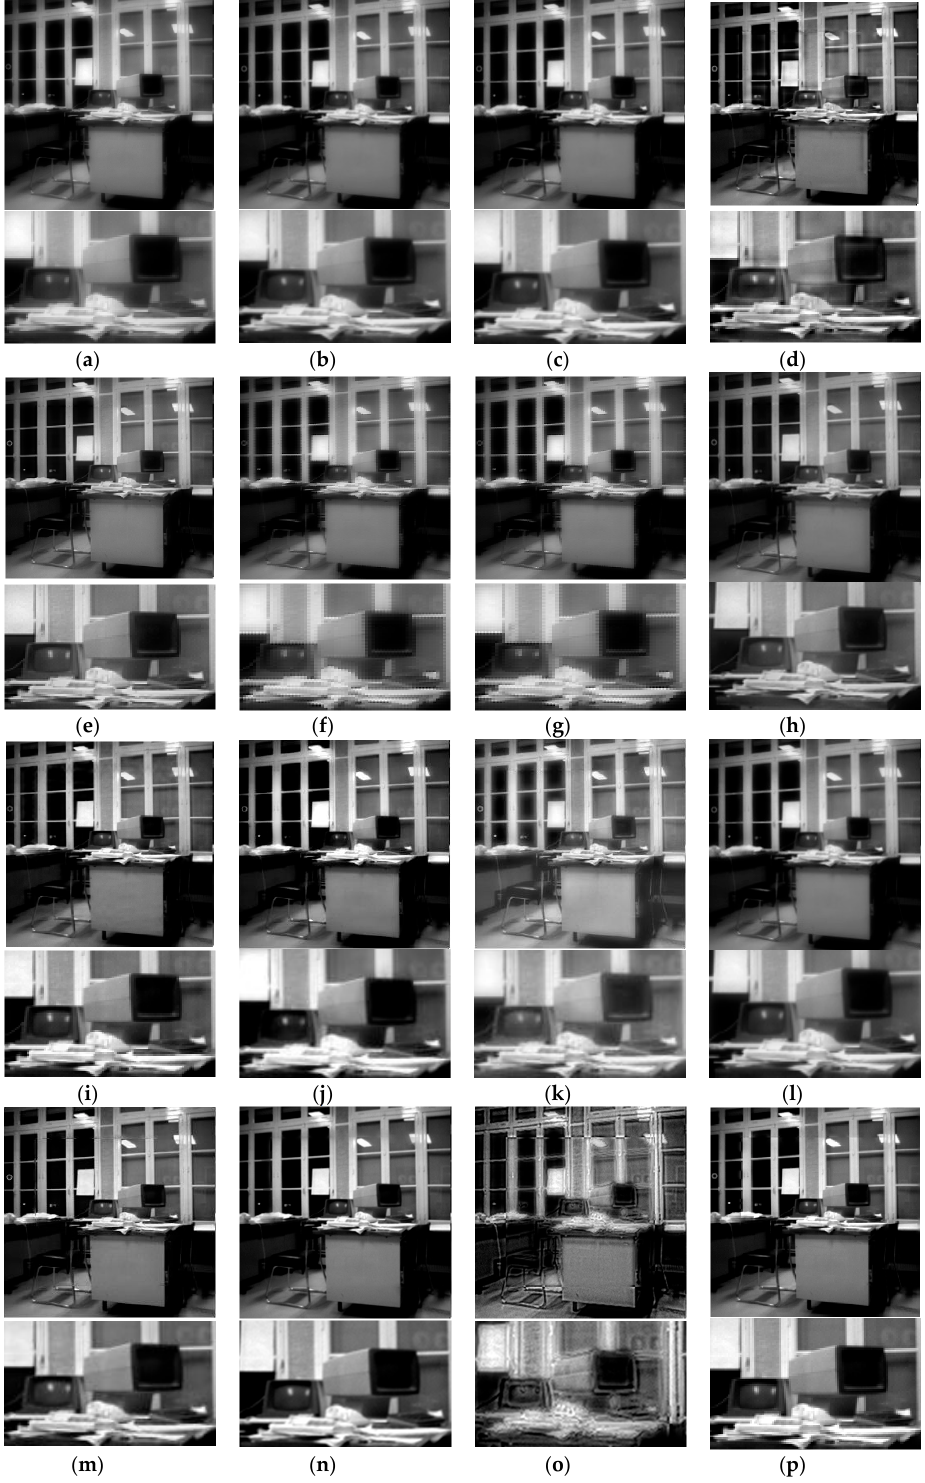
Figure 6. Fused images obtained by di ff erent methods in the image pair “o ffi ce”. ( a ) PCA; ( b ) SWPCA; ( c ) MWPCA; ( d ) DWT; ( e ) GP; ( f ) MSVD; ( g ) CSR; ( h ) FSD; ( i ) DCHWT; ( j ) MGFF; ( k ) MMGD; ( l ) SWT; ( m ) LPPCNN; ( n ) BRWIF; ( o ) FPED; ( p )